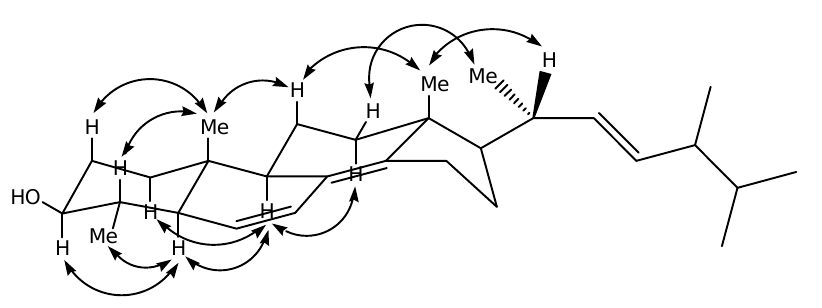
Figure 3. Key NOESY correlations of 1 .